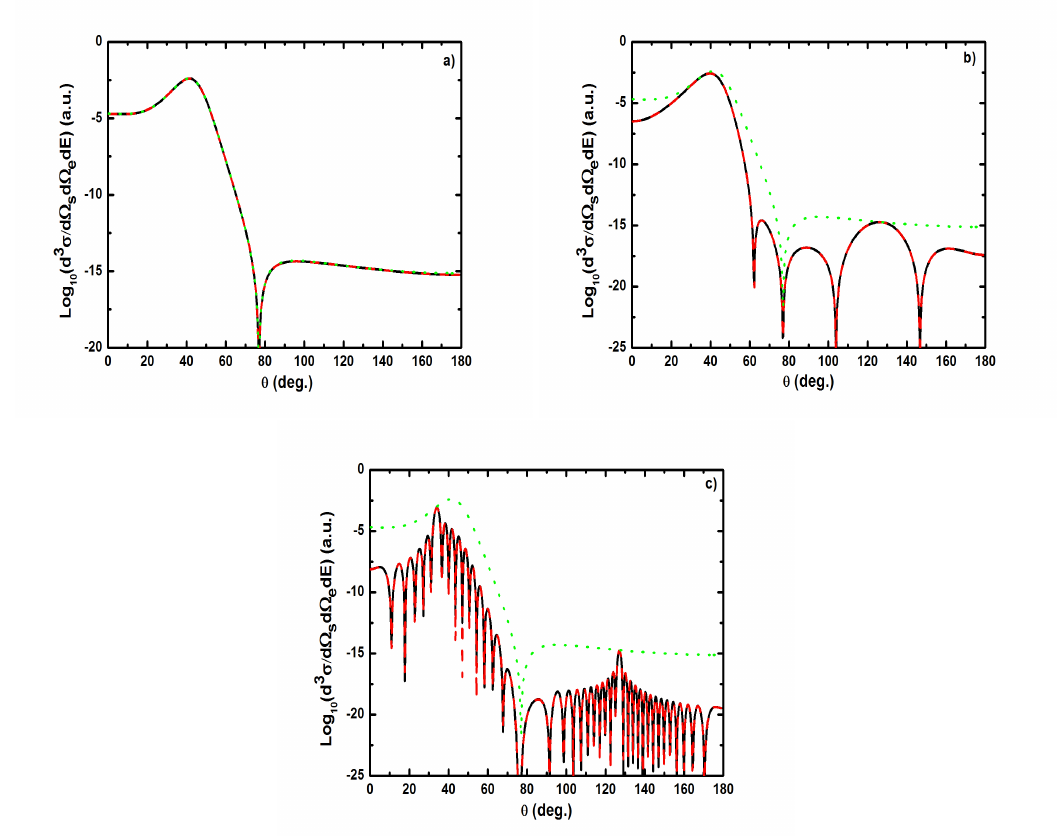
Figure 24. Triple differential cross sections corresponding to laser-assisted electron-impact ionization of atomic hydrogen in the ground state for the case of a coplanar symmetric geometry as a function of the scattering angle θ = θ s = θ e for no net exchange of photons ( (cid:96) = 0). The incident electron energy is = 250 eV, the laser frequency is ω = 1.17 eV and the electric field strength is ( a ) E E k i ( b ) E 0 = 10 7 V/cm and ( c ) E 0 = 10 8 V/cm. The laser polarization vector is taken to be parallel to the incident momentum k i . Solid lines: First Born approximation results. Dashed line: results obtained by neglecting the dressing of the target by the laser field. Dotted lines: field-free